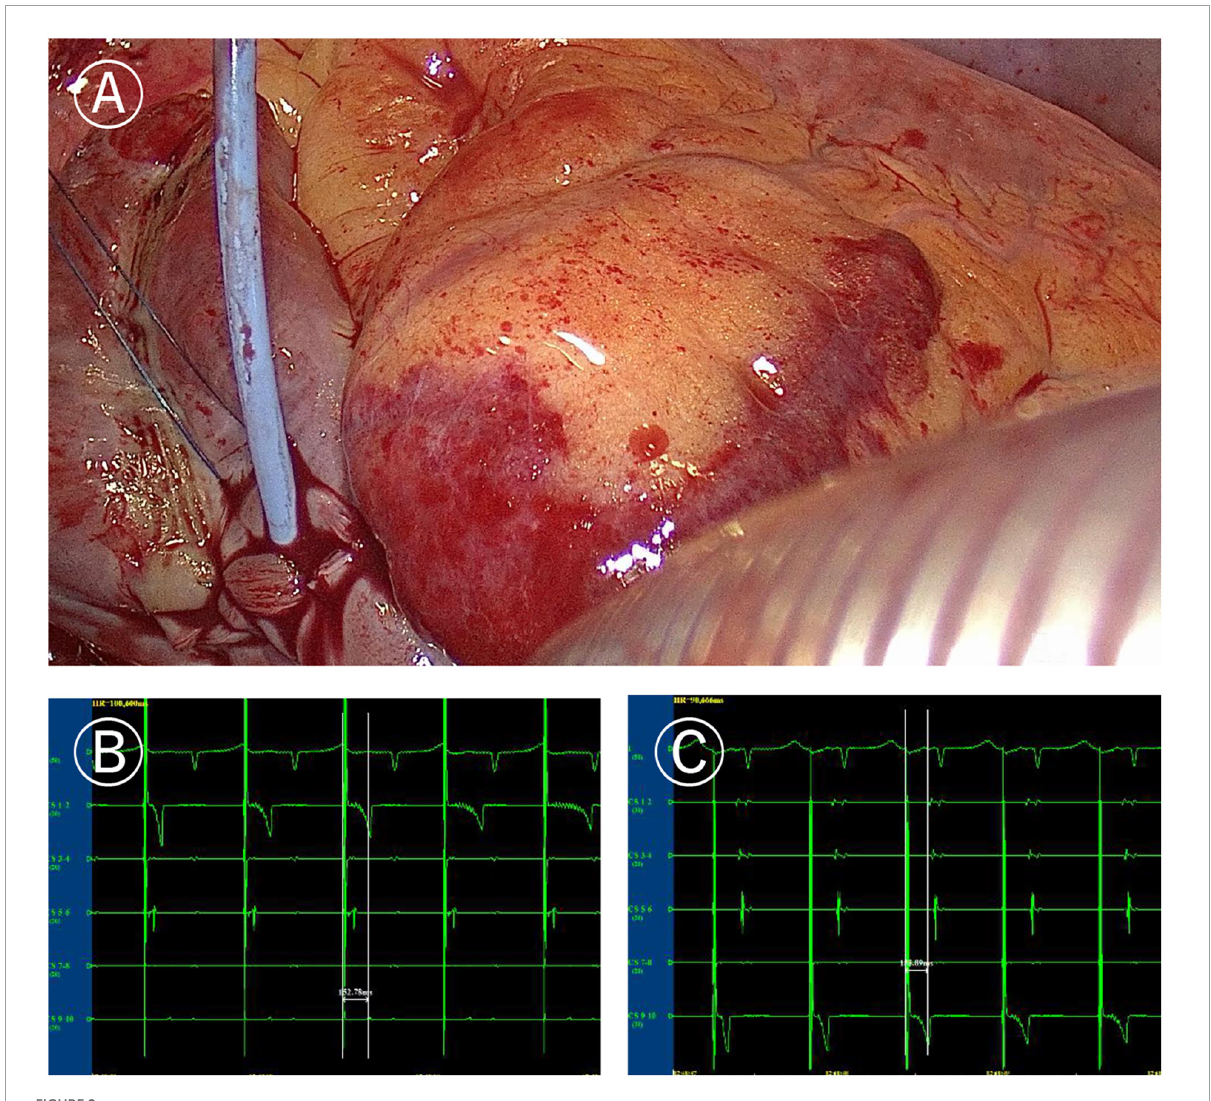
FIGURE2 Ablation line mapping of mitral isthmus. (A) Coronary sinus catheter mapping of mitral isthmus ablation line. (B) Distal (CS1-2) delay during proximal (CS9-10) pacing of coronary sinus catheter (more than 120 ms). (C) Proximal delay during distal pacing of coronary sinus catheter (more than 120